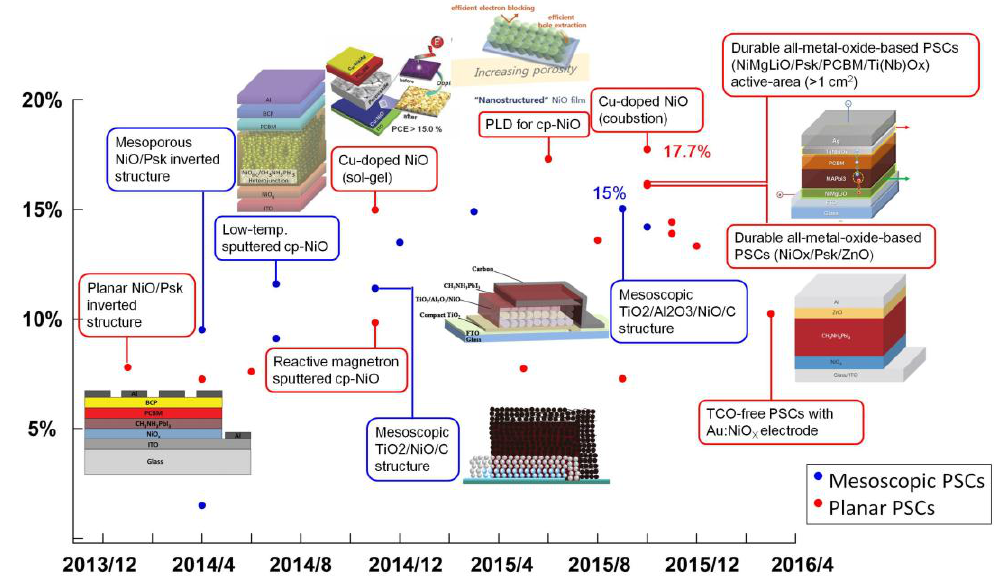
Figure 4. Power conversion efficiency (PCE) evolution of NiO-based organometallic lead halide perovskite solar cells (PSCs). C, carbon; cp, compact film; PLD, pulse laser deposition; Psk, perovskite; TCO, transparent conductive oxide.